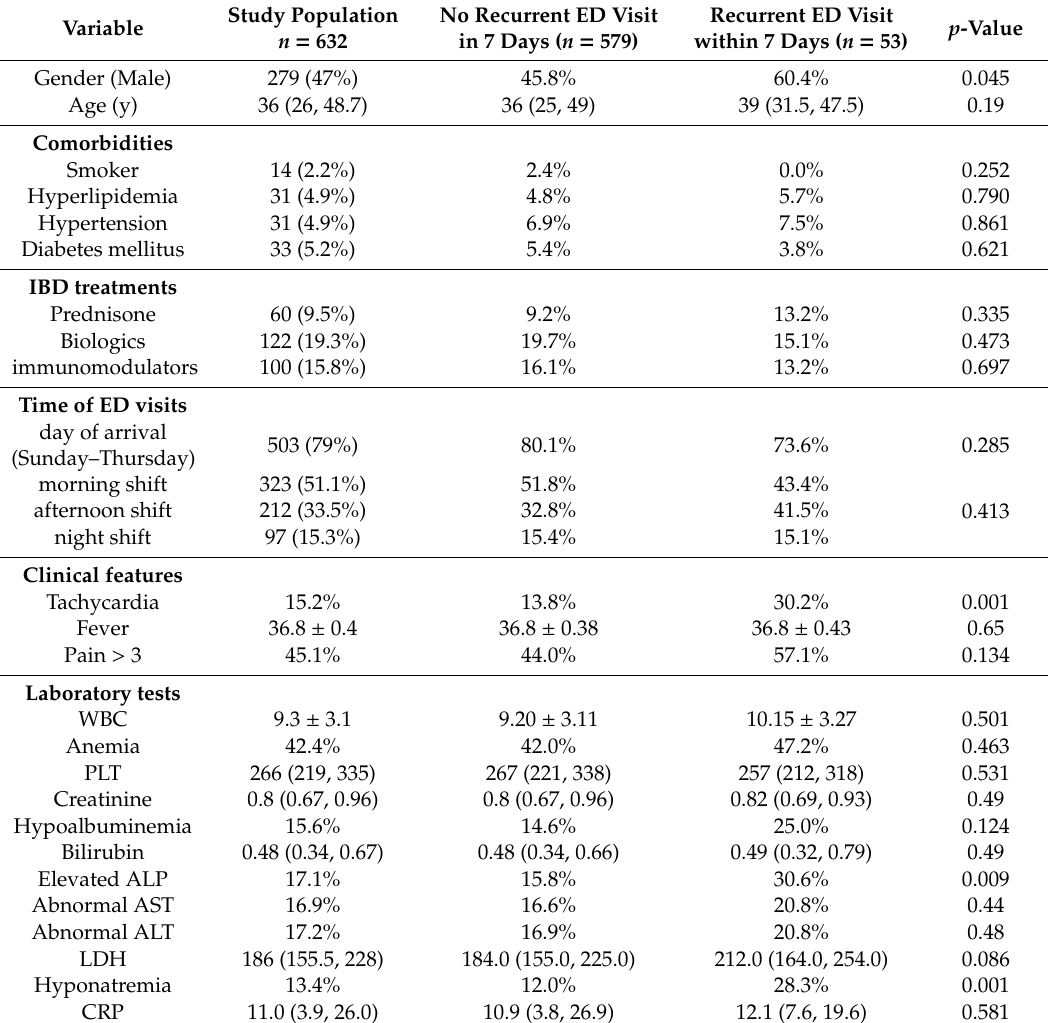
Table 1. Characteristics of the study population and controls. Re-visits after 7